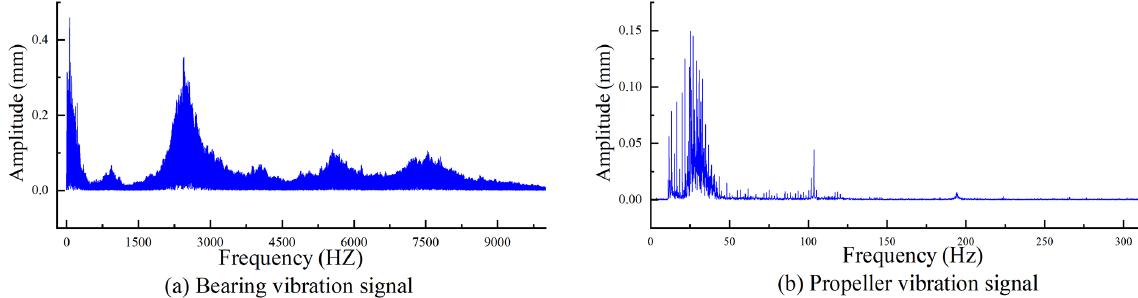
Figure 4. Frequency analysis of the vibration signals.